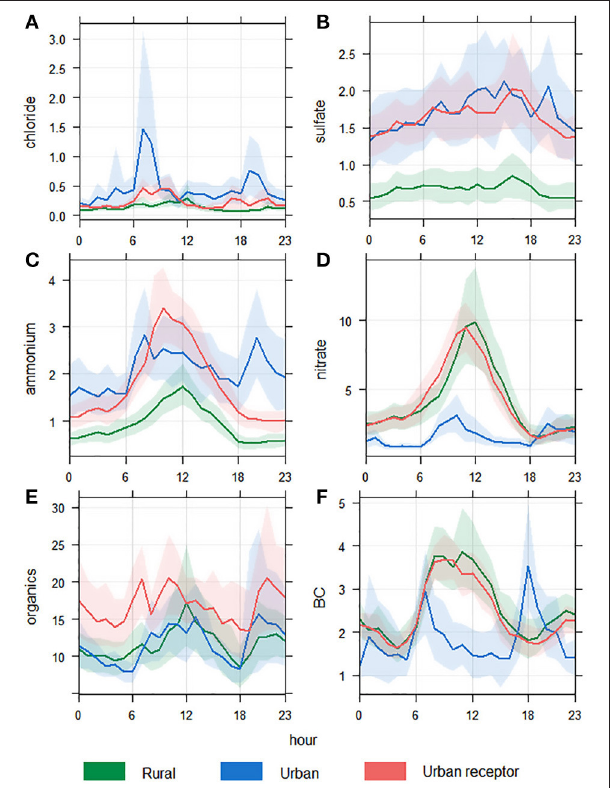
FIGURE 8 | Hourly temporal profile of 1-h average concentrations ( µ g m − 3 ) during the spring season. (A) chloride, (B) sulfate, (C) ammonium, (D) nitrate, (E) organics, (F) black carbon. Mean (solid line) and 95% confidence intervals in the mean (darkened area).